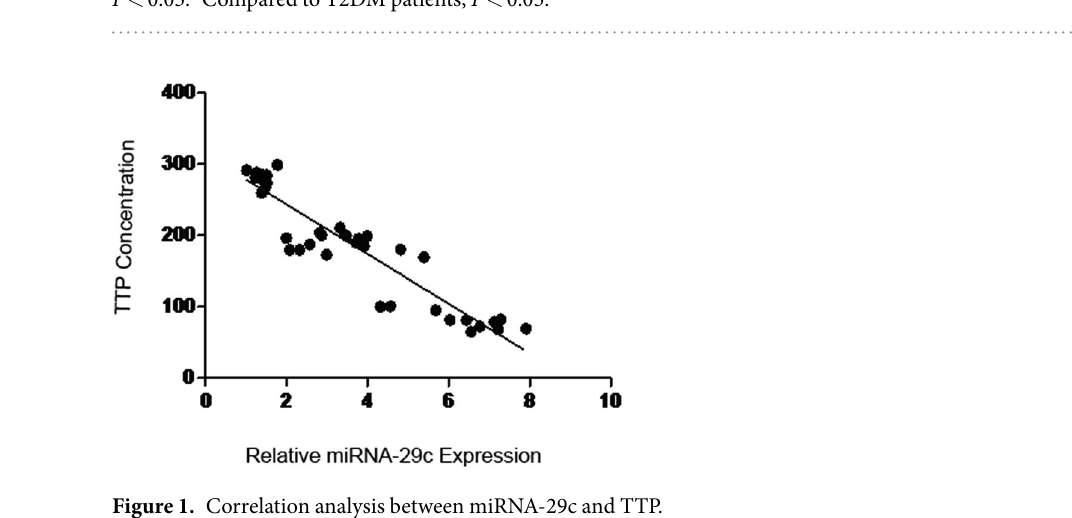
Figure 1. Correlation analysis between miRNA-29c and TTP.